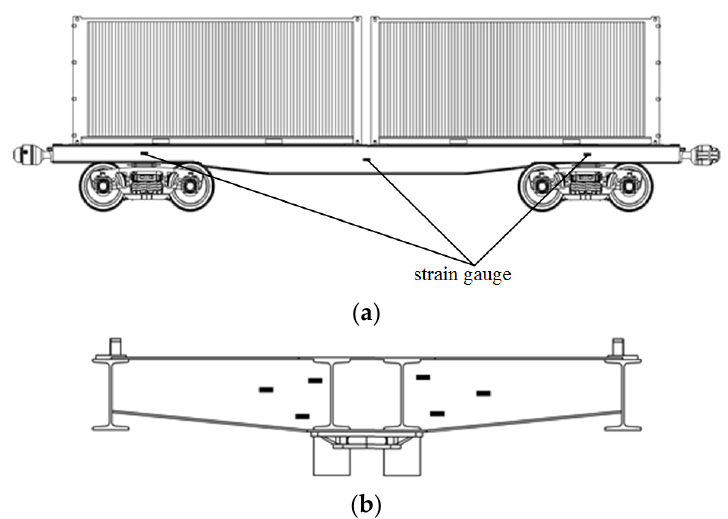
Figure 6. Strain gauges on the frame: ( a ) on the side beam; ( b ) on the body bolster.